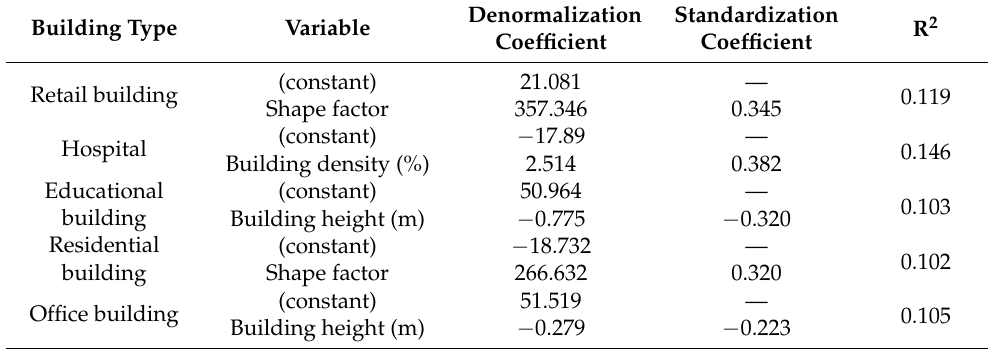
Table 4. Stepwise regression results of urban morphology factors and building electricity EUI.